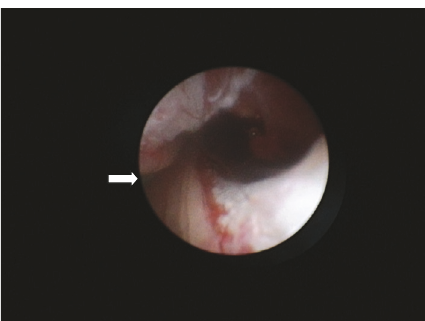
Figure 1: Ureterorenoscopic findings after the misplaced transur- ethral catheter was removed. The image was taken right after the transurethral catheter’s balloon block was deflated and the catheter was pulled back into the bladder. On the left edge of the picture (white arrow) the guide-wire being in situ in the ureter can be seen. In the center of the picture the ruptured ureter shows way into the retroperitoneal space.